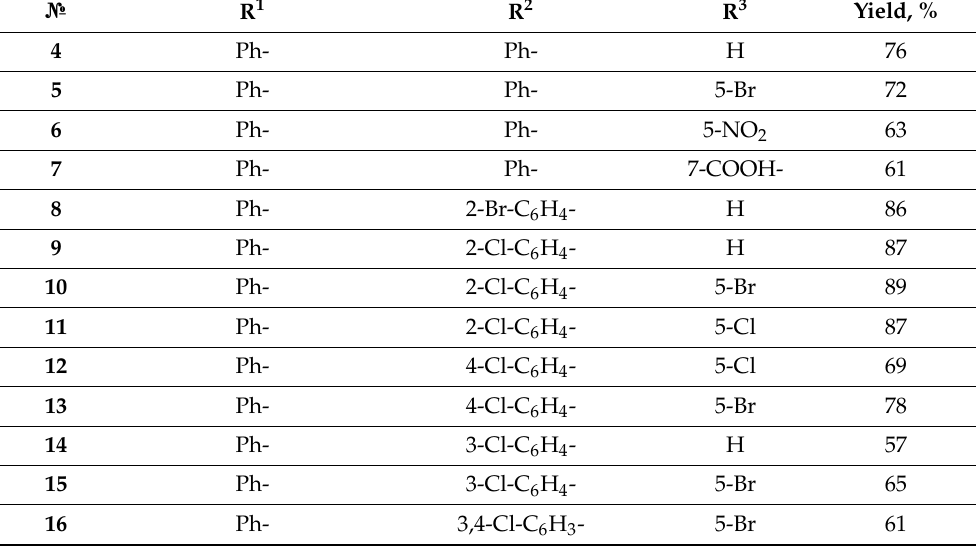
Table 1. Structures and yields of compounds 4 – 69